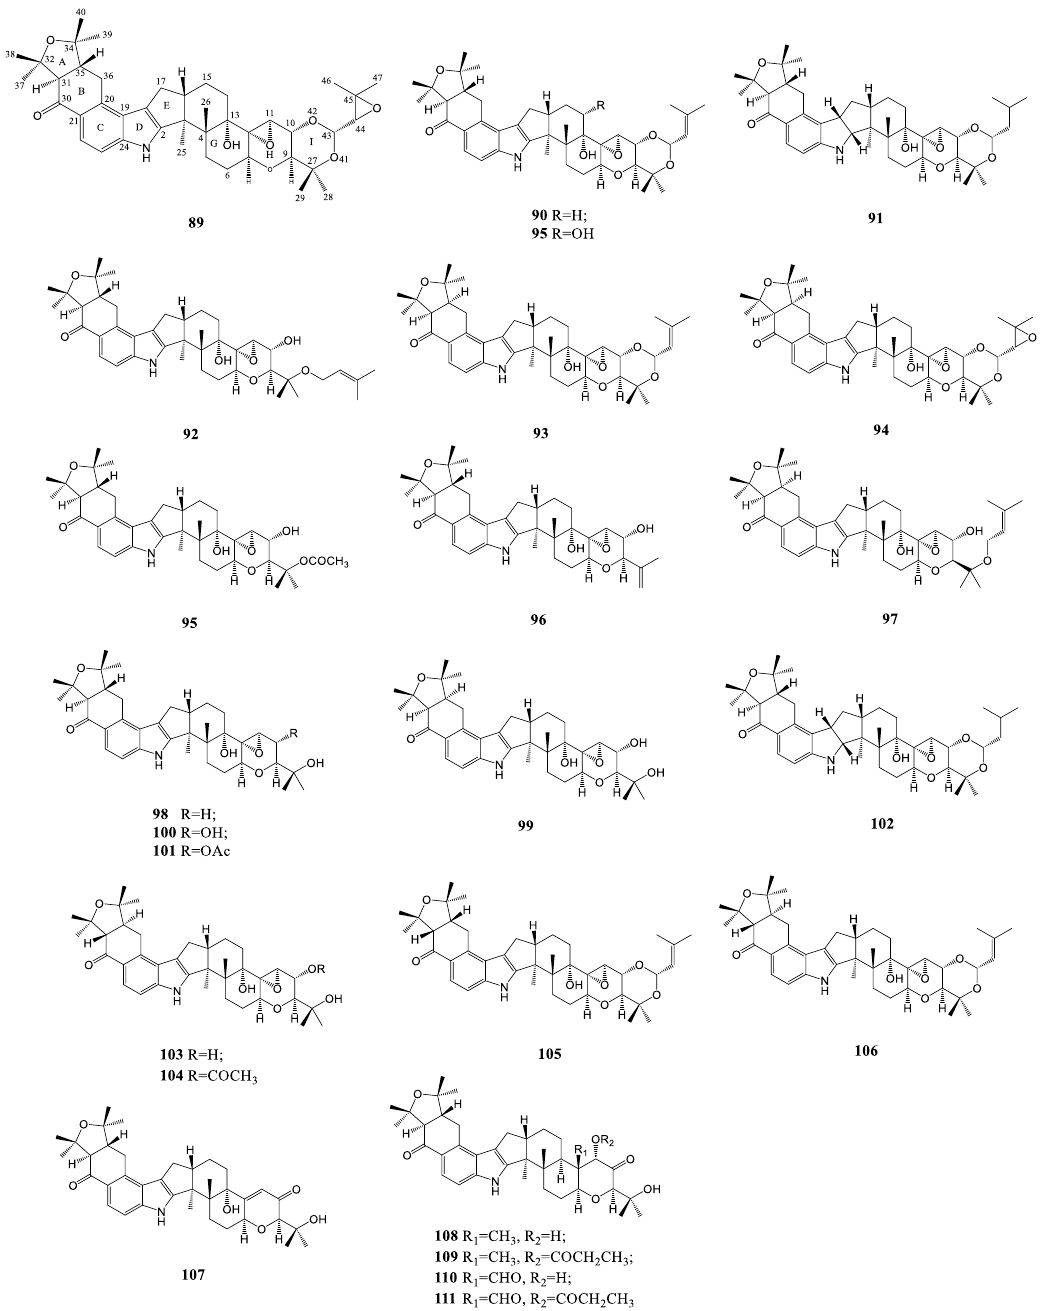
Figure 5. Lolitrem-like indole diterpenoid compounds ( 89 – 107 ).